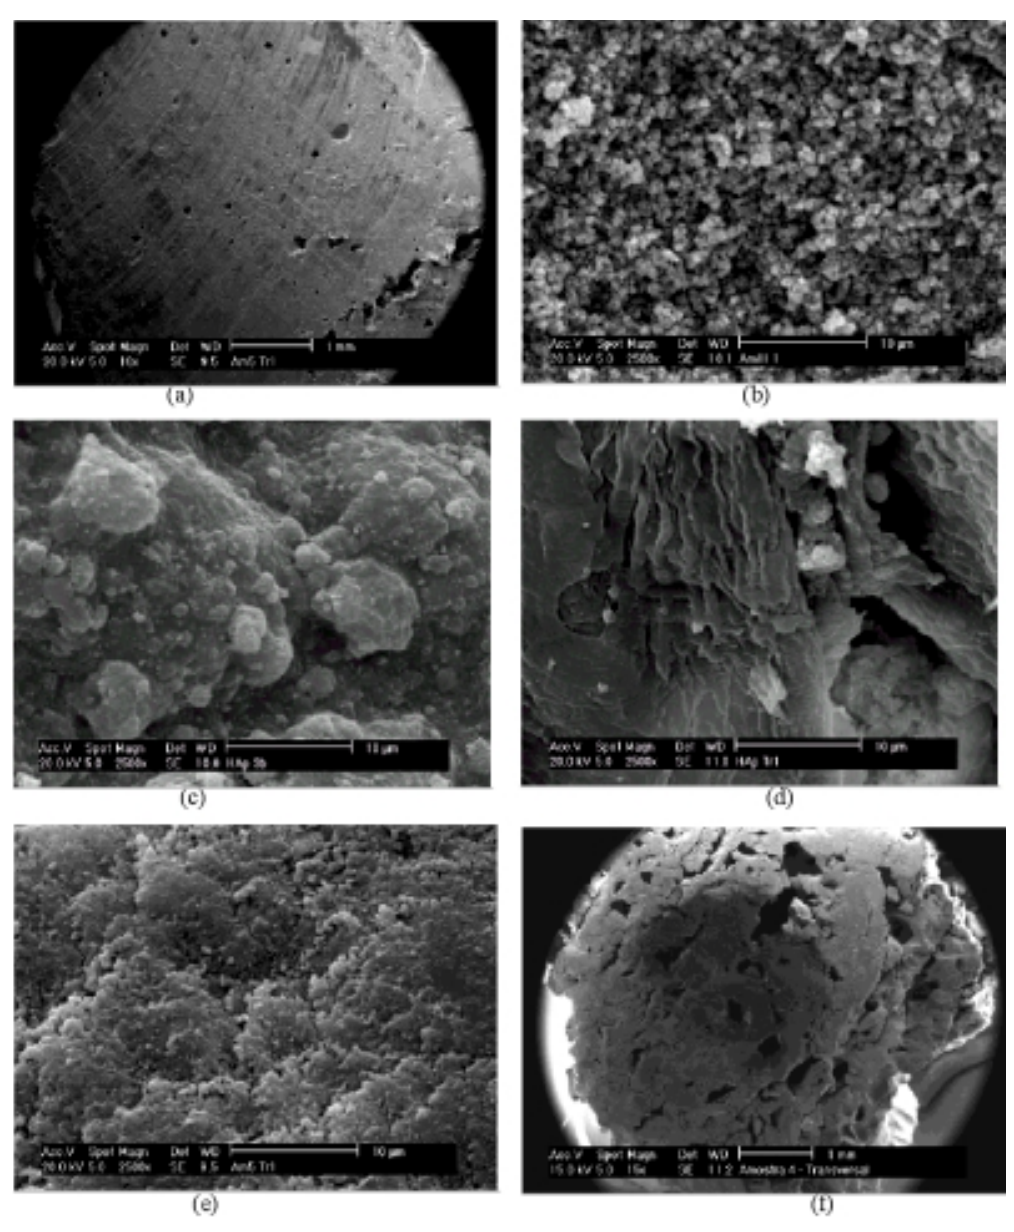
Fig. 3 – SEM micrograph results from: (a) compositeV, (b) composite III, (c) composite III (from HApIII), (d) composite I transversal section, (e) composite V transversal section, and (f) composite IV transversal section (with 0.3% Aluminum